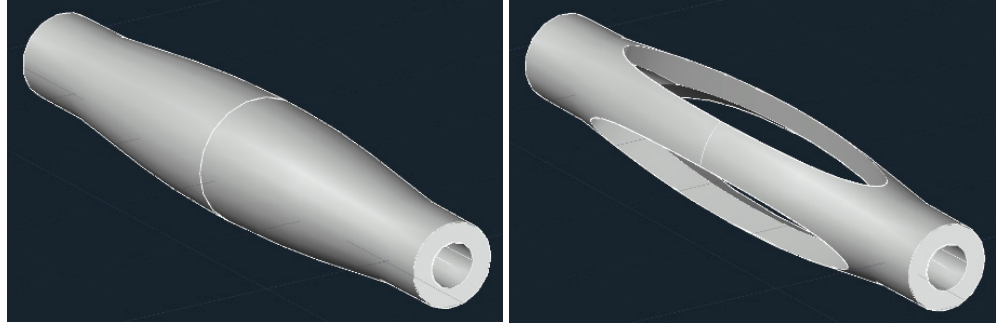
Figure 4. Cell ellipsoid geometry ( left ), three-arm configuration ( right ).